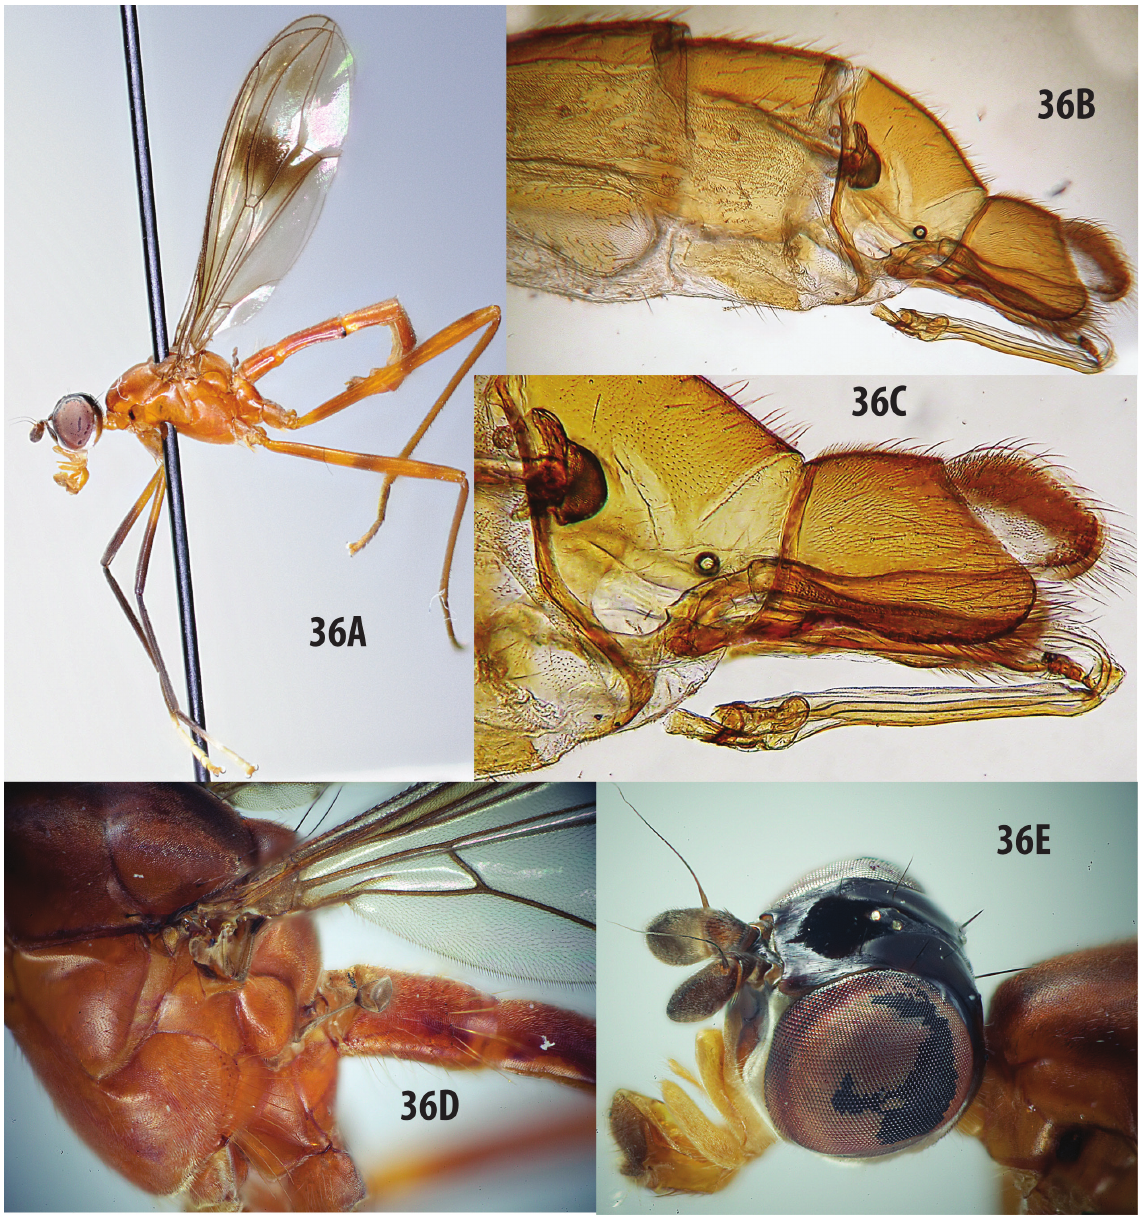
Fig. 36. Mesoconius uchumachi sp. nov., holotype, ♂, CBFC. A . Entire specimen. B–C . Abdominal apex. D . Thorax and base of abdomen. E . Head and anterior part of